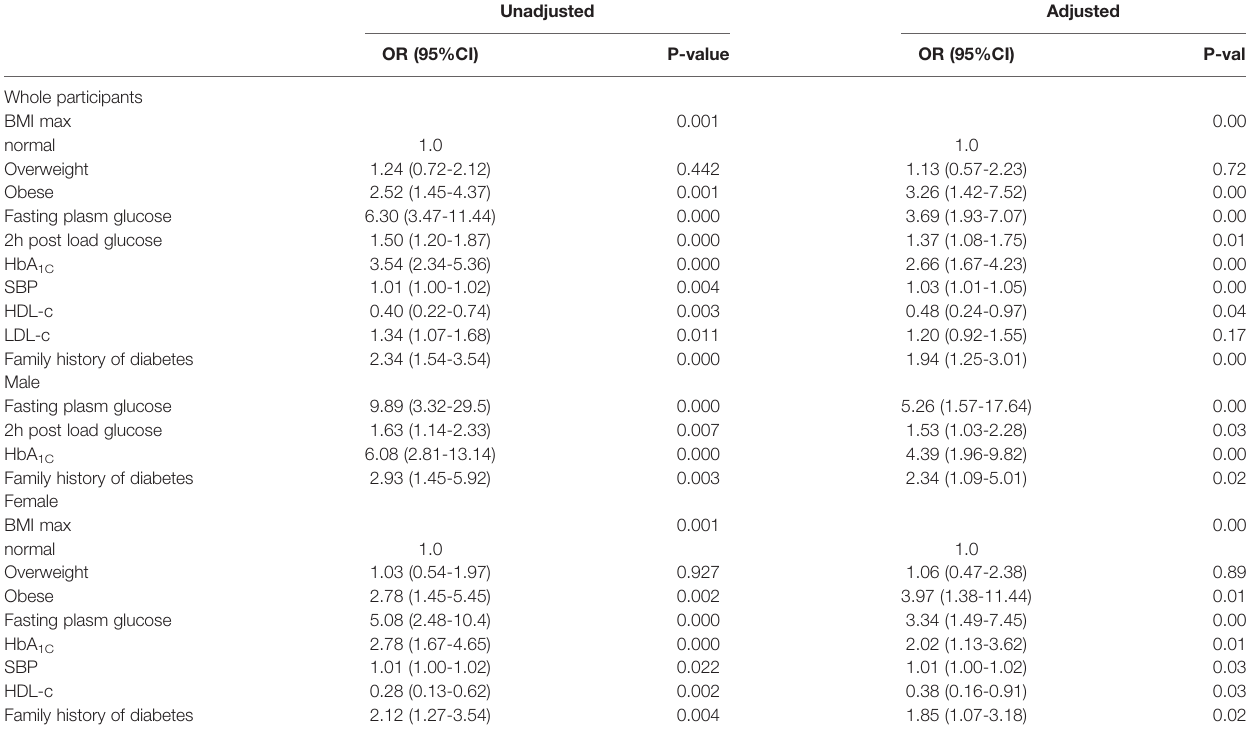
TABLE 2 | Crude and multivariable-adjusted relative risk of related factors for diabetes. Unadjusted Adjusted OR (95%CI) P-value OR (95%CI)